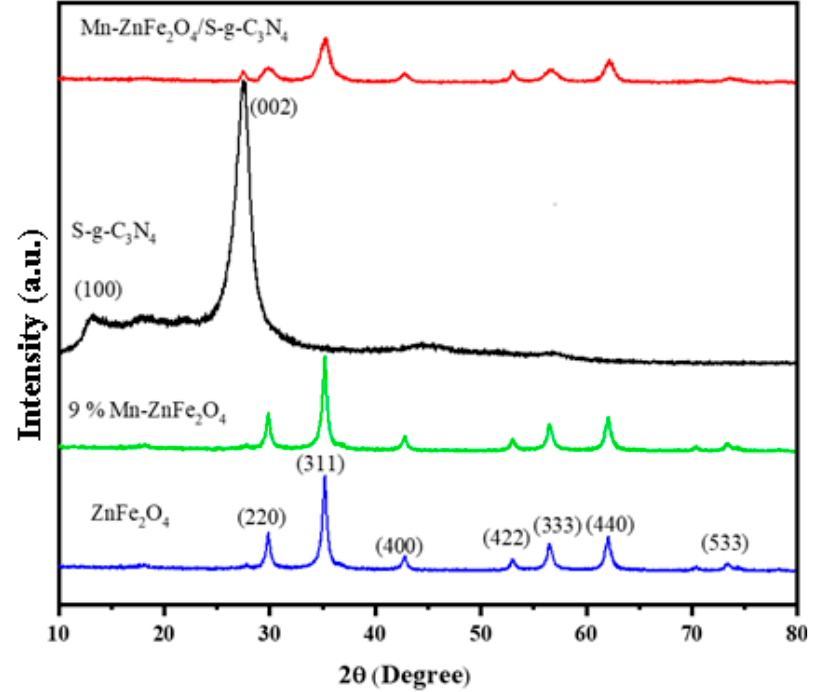
Figure 3. XRD spectrum of ZnFe 2 O 4 , 9% Mn-ZnFe 2 O 4 , S-g-C 3 N 4, and 9% Mn - ZnFe 2 O 4 /50% S-g-C 3 N 4 .